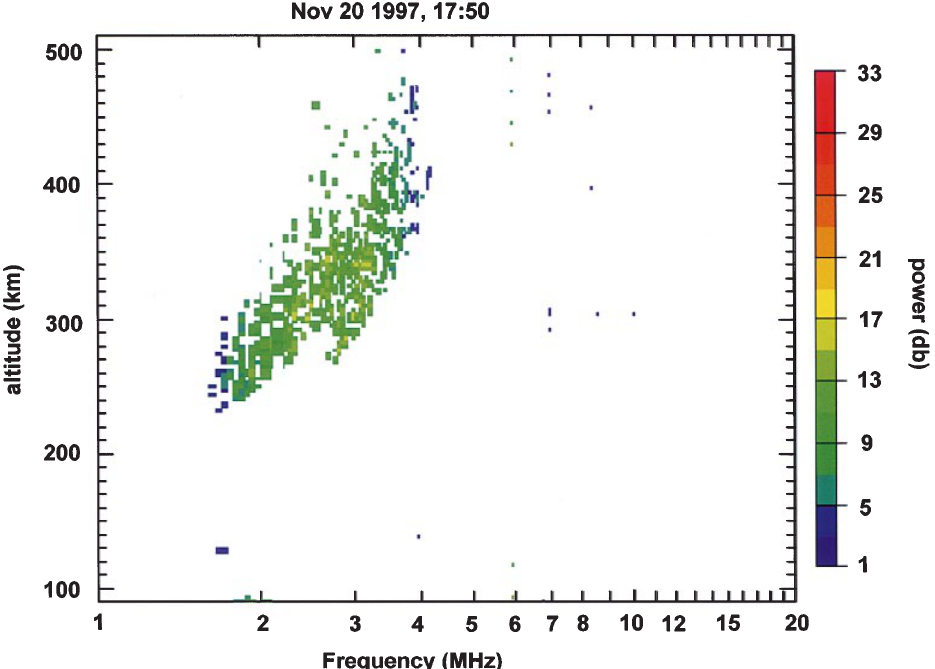
Fig. 7. Ionogram for 1750 UT on 20 November, 1997. The small area of signal at about 125 km virtual height is con- sidered to represent the rem- nants of an Es layer observed some 25 min earlier. The same feature is visible on the preced- ing ionogram at 1735 UT (not included here). The colour cod- ing denotes